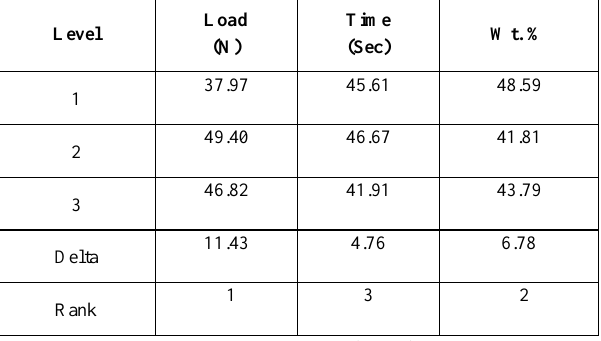
Table 7: Response Table for Signal to Noise Ratios at speed of 2.5m/s (High speed).